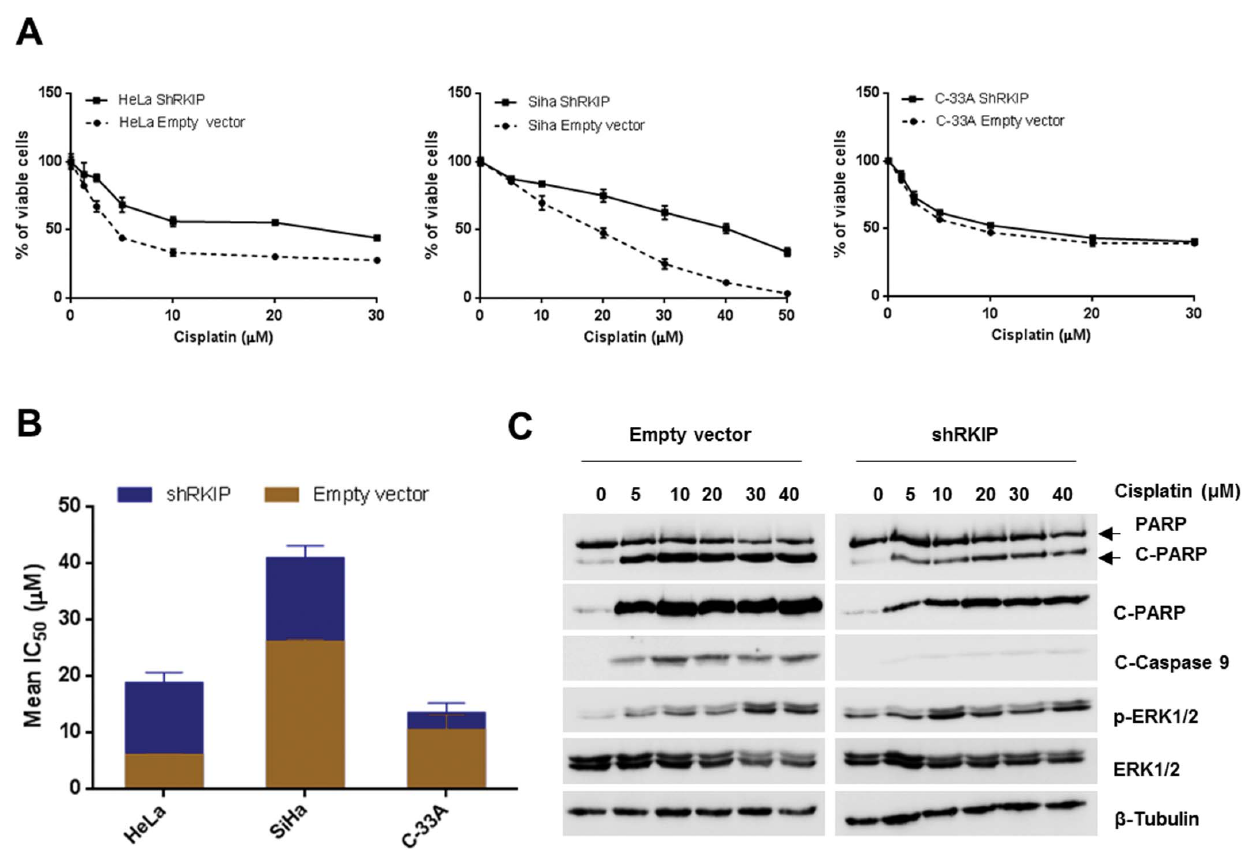
Figure 5. Role of RKIP in cervical cancer cells response to cisplatin. A) Representative pictures of the nonlinear regression analysis of cervical cancer cell lines treated with cisplatin for determination of half maximal inhibitory concentrations (IC 50 ). B) Graphic representation of the mean IC 50 values for cisplatin in the cervical cancer cell lines. The transfected cells with shRKIP were less sensitive to cisplatin treatment in the three different cell lines. C) HeLa transfected cell lines were exposed to increasing concentrations of cisplatin by 24 hours. Cisplatin treatment induced ERK activation (p- ERK1/2) and apoptosis of the cells as evaluated by PARP (total and cleaded specific antibodies) and caspase-9 cleavage, mainly in the empty vector transfected cells. All the experiments were done in triplicate at least three times. Data in the panels A and B are represented as the mean 6